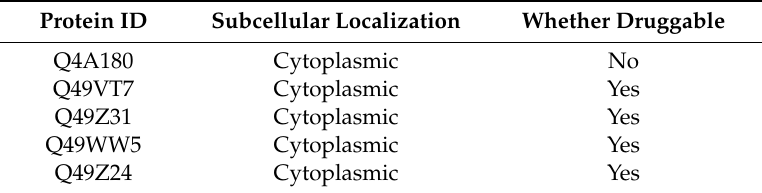
Table 2. Subcellular localization prediction of proteins involved in